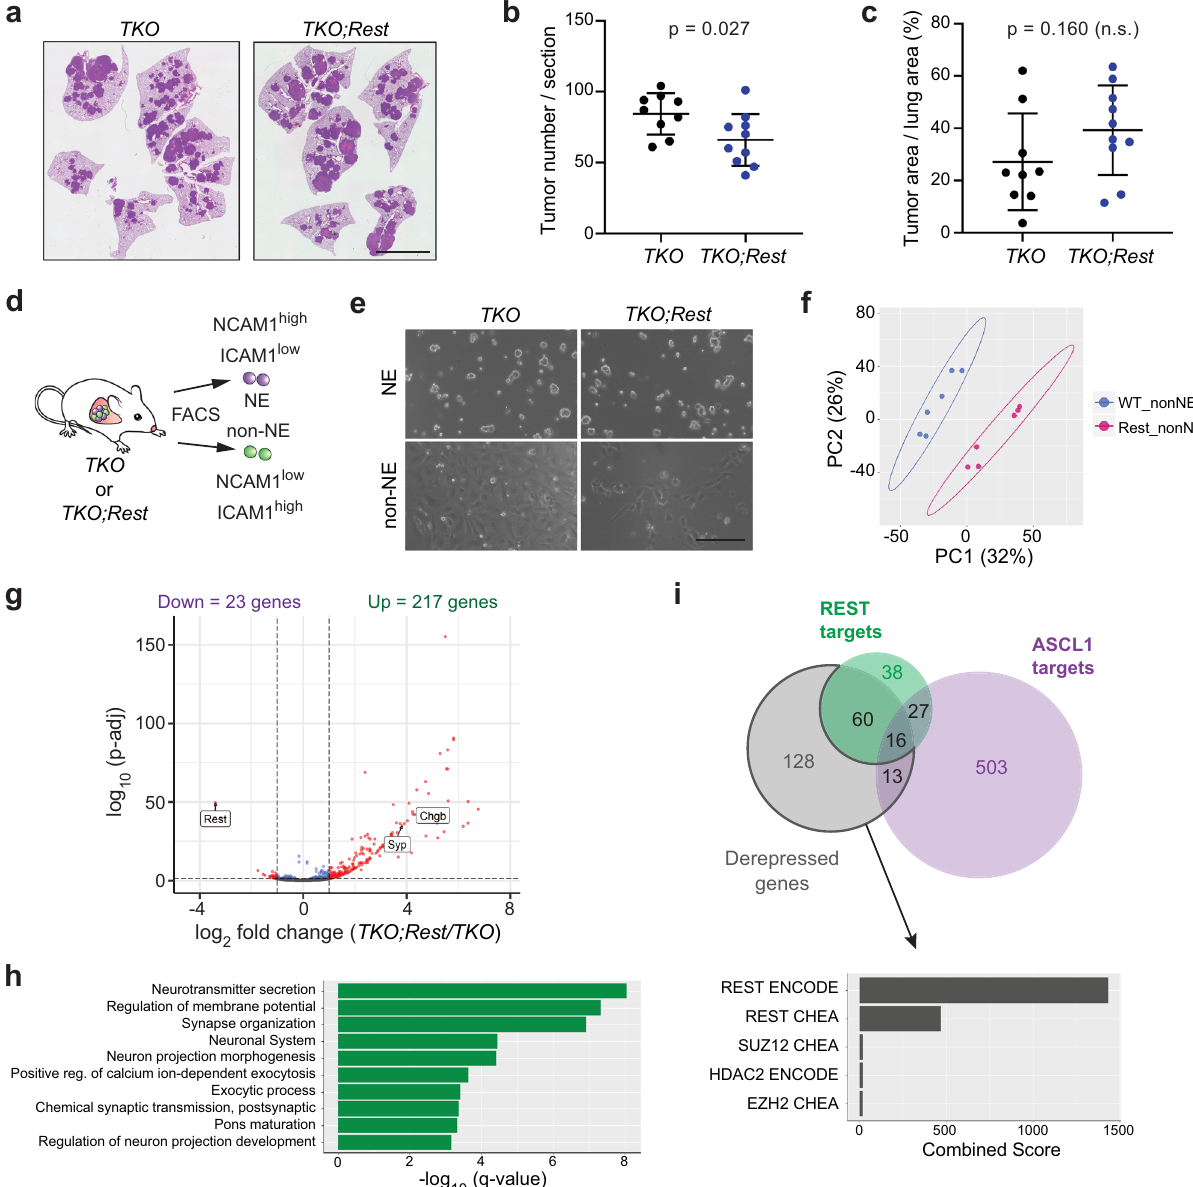
Fig. 3 Loss of REST prevents the repression of its neuroendocrine targets in SCLC cells. a – c Representative images of lung sections from TKO and TKO ; Rest fl / fl mice 5 months after Ad-CMV-Cre ( TKO ; Rest , quadruple mutant), stained with hematoxylin and eosin (H&E). Scale bar, 5 mm. Quanti fi cation of tumor numbers ( b ) and tumor area ( c ) ( n = 9 mice for TKO and 10 mice for TKO ; Rest fl / fl ). Error bar, mean ± s.d. d and e Schematic representation ( d ) and representative bright fi eld images ( e ) of neuroendocrine (NE) and non-NE cells sorted from TKO and TKO ; Rest mutant tumors based on NCAM1 and ICAM1 expression. Scale bar, 200 μ m. f Principal component analysis (PCA) of RNA-seq data comparing non-NE cell lines generated from TKO and TKO ; Rest mutant tumors ( n = 6 per genotype). WT wild-type for Rest ; “ Rest ” , knockout for Rest . g Volcano plot of differentially expressed genes from RNA- seq data of TKO and TKO ; Rest mutant non-NE cell lines. Rest and the classical neuroendocrine markers Syp / Chgb are highlighted (signi fi cant genes with more than 2-fold change and p -adj value < 0.05 are in red). Wald test with Benjamini – Hochberg correction. h Gene Ontology (GO) analysis of the upregulated genes in the TKO ; Rest mutant non-NE cell lines. i Venn diagram showing the amount of overlap between derepressed genes of TKO ; Rest mutant non-NE cell lines with REST and ASCL1 targets identi fi ed in Fig. 2. Bar graph showing top 5 candidate transcription factors from Enrichr analysis (ENCODE and ChEA Consensus TFs from ChIP-X) on the 141 derepressed genes that did not overlap with our REST targets. See also Supplementary Figs. 5 and 6 and Supplementary Data 10 and 11. Source data are provided as a Source Data fi